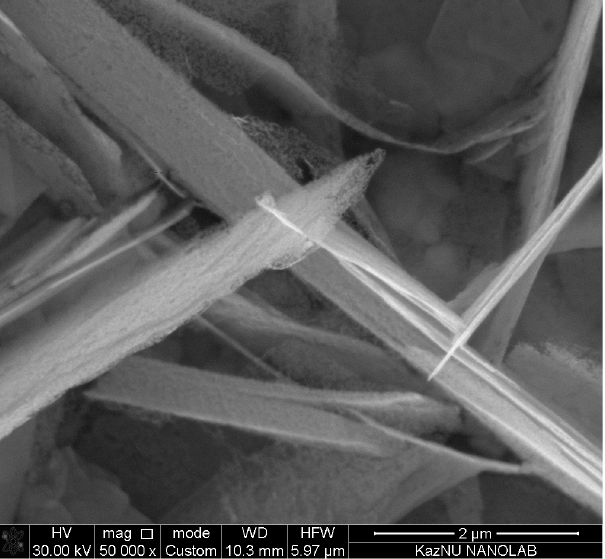
Figure 6. SEM image of ZnO NS coatings served four cycles as glucose concentration sensor.